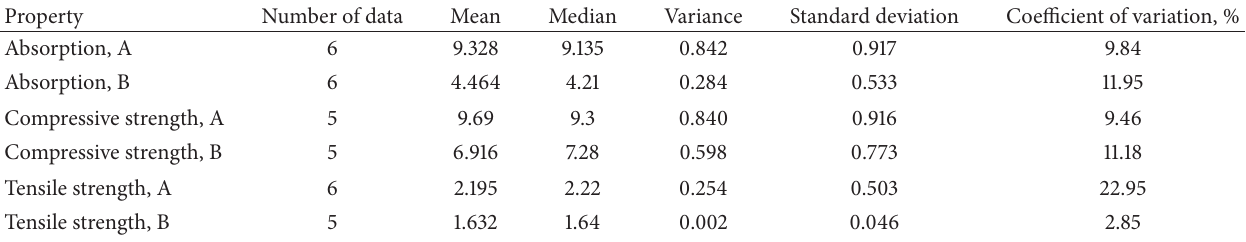
Table 1: Statistical evaluation of absorption (%), Compressive and tensile strength (MPa) of A and